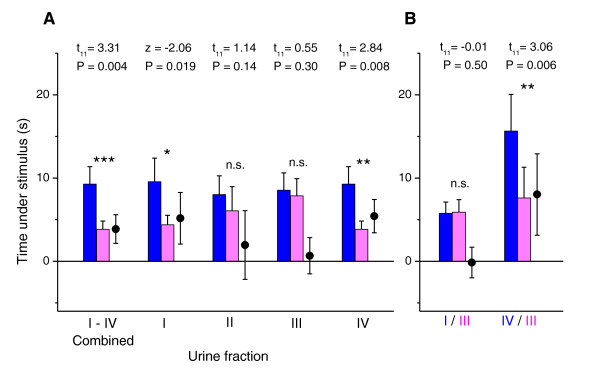
Female sexual attraction to urine fractions separated by anion exchange chromatography containing different major urinary proteins (MUPs). Total time spent under urine stimuli from B6 males (blue bars) and from matched females (pink bars), together with the difference in time spent under male minus female fraction (circles), plotted as means ± standard error of mean. Significant P values indicate greater attraction to the male stimulus (matched pair t-tests of log transformed data (t) or Wilcoxon matched pair tests (z) when log transformed data did not approximate normality); n.s. = no significant attraction to male. (A) Response to urine fractions containing different MUPs (separation shown in Figure 2). I: 18645Da MUP (in male fraction only); II: 18709Da MUP (both sexes); III: 18694Da and 18713Da MUPs (both sexes); IV: 18893Da MUP (darcin, male only). The protein concentration in each male and female fraction is given in Table 2. (B) Male fractions I and IV were subsequently tested against female fraction III. For each test n = 12 except fraction I which bordered on significance and sample size was increased to n = 17.